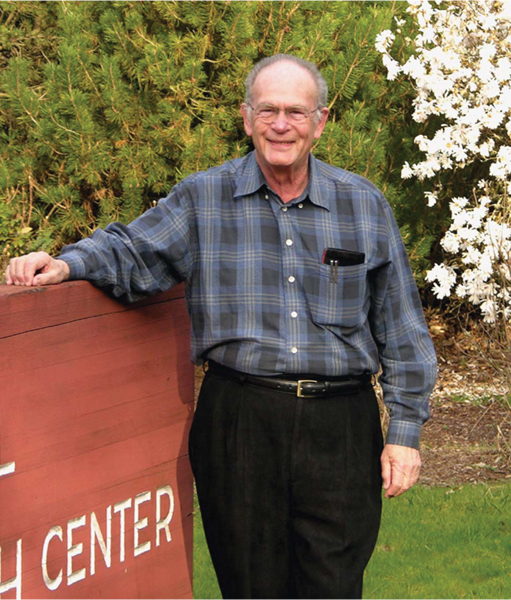
Dr Robert M Brenner.